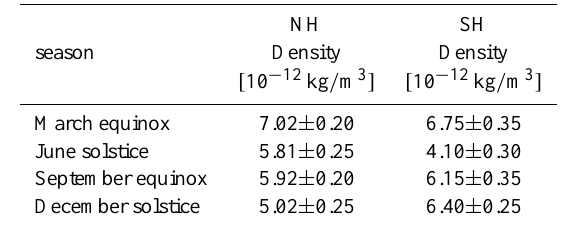
Table 2. Average ambient mass density in the cusp region at a flux level P10.7 = 150, separated by season and hemisphere. The data are adopted from Liu et al.